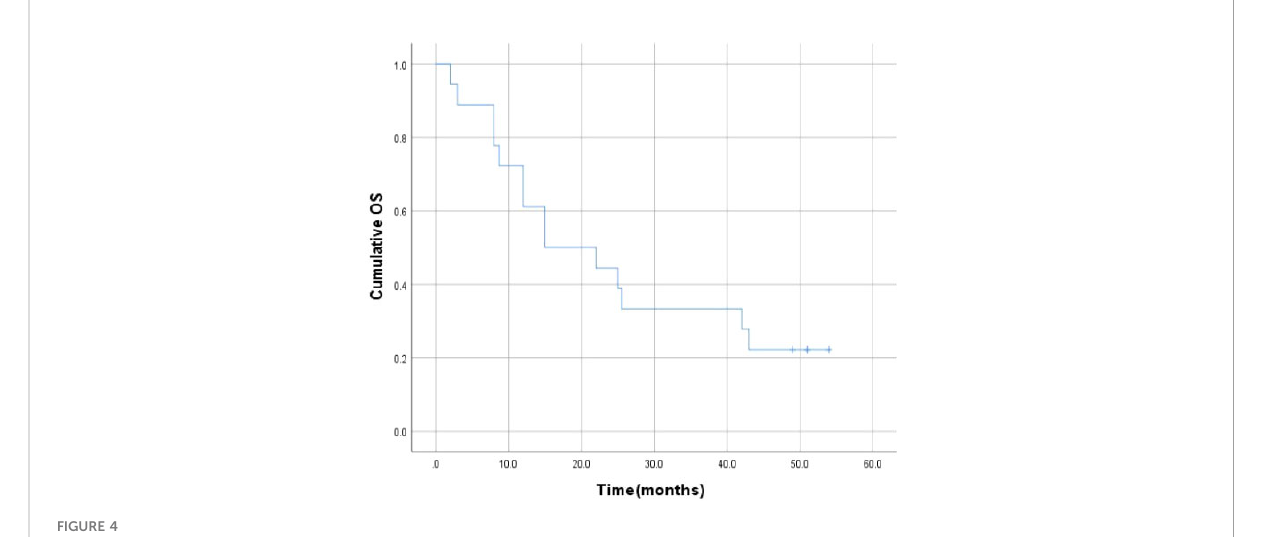
FIGURE 4 Cumulative OS for all